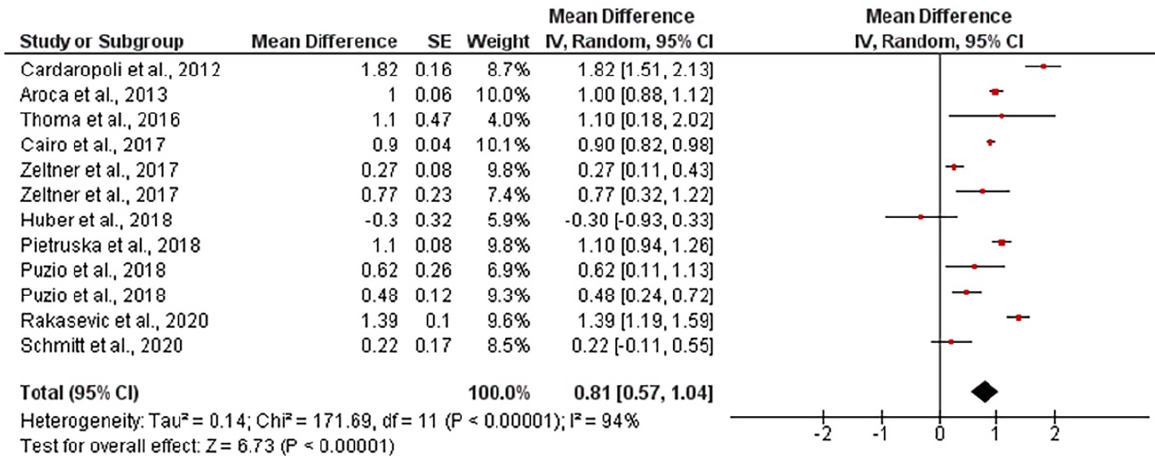
Figure 10. Forest plot for gingival thickness in test group (collagen matrix). The weighted mean is presented at CI 95%. Heterogeneity was determined using Higgins (I 2 ). A random-effects model was applied. Statistical significance was set at 0.05.